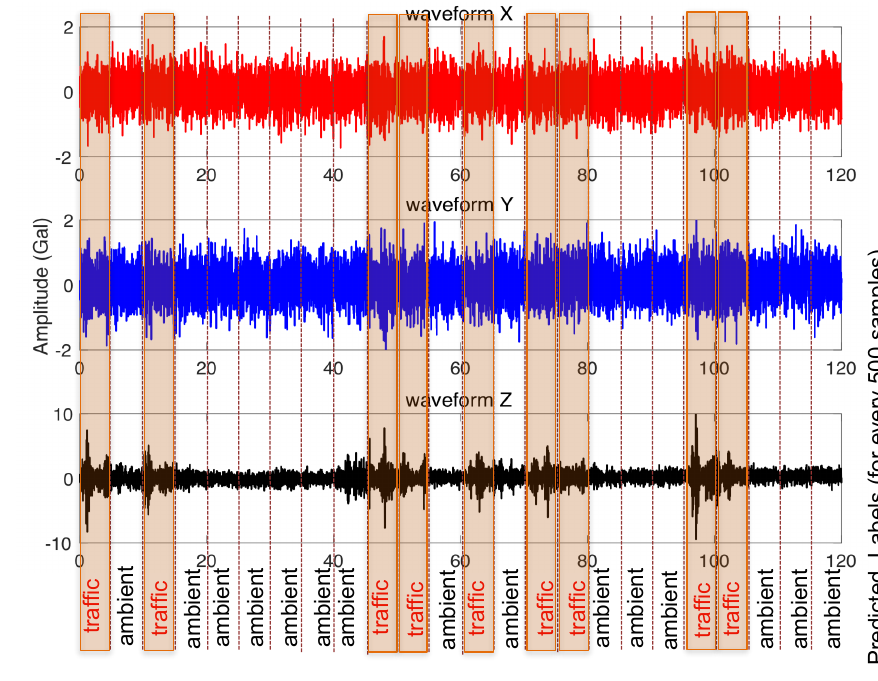
Figure 17. In-device prediction (classification) of vibration data.